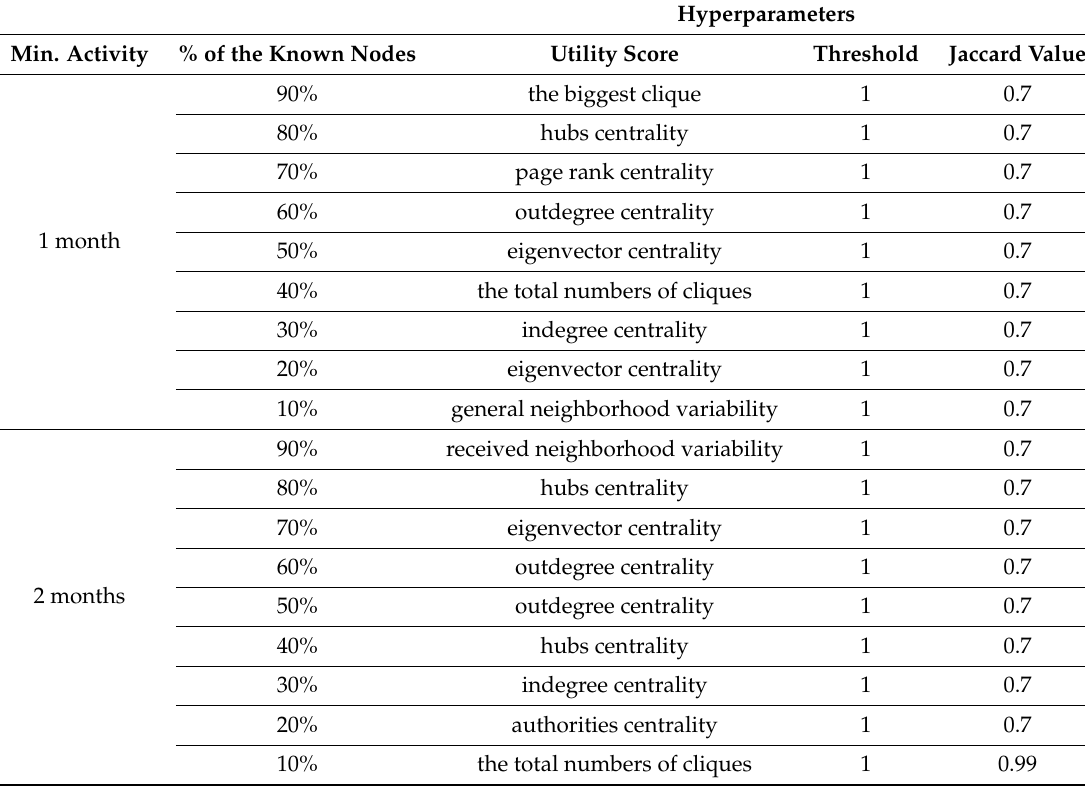
Table A31. The best values of the hyperparameters for the collective classification algorithm for the Enron dataset with three hierarchy